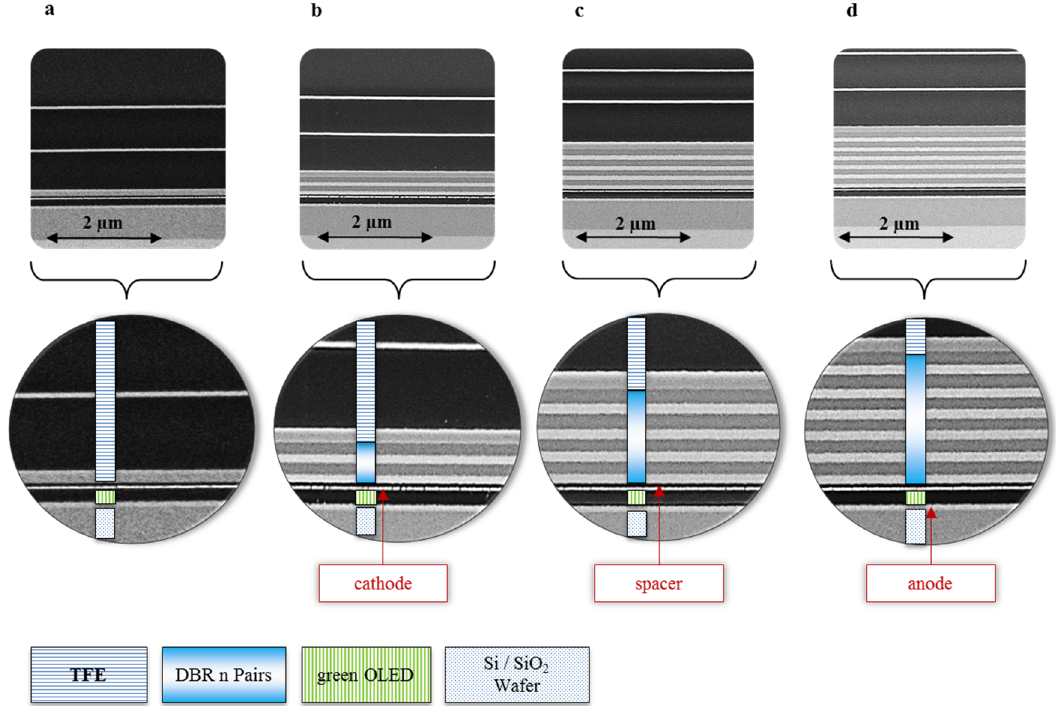
Figure 2. Cross section of the OLED devices including the variation of DBR layer and fixed TFE-thicknesses, ( a ) shows the reference OLED; ( b ) shows two pairs of DBR on top of OLED including TFE (2.0 kV/1.6 mm × 20.0 k); ( c ) shows four pairs of DBR (2.0 kV/1.8 mm × 20.0 k) and ( d ) exhibits six pairs of DBR above the OLED and below the TFE with (2.0 kV/2.3 mm × 20.0